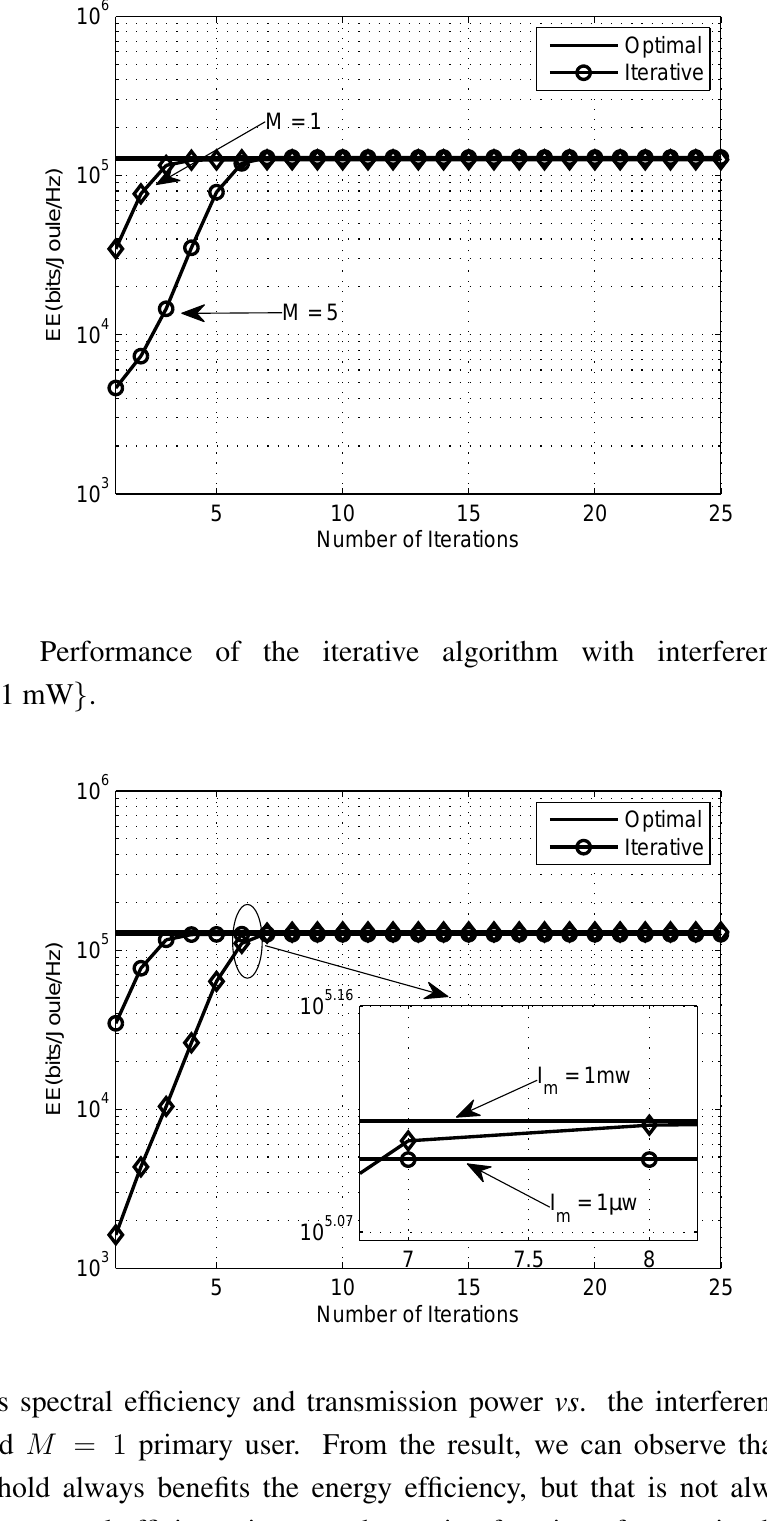
Figure 5. Performance of the iterative algorithm with the number of PUs, M = { 1,5 } .